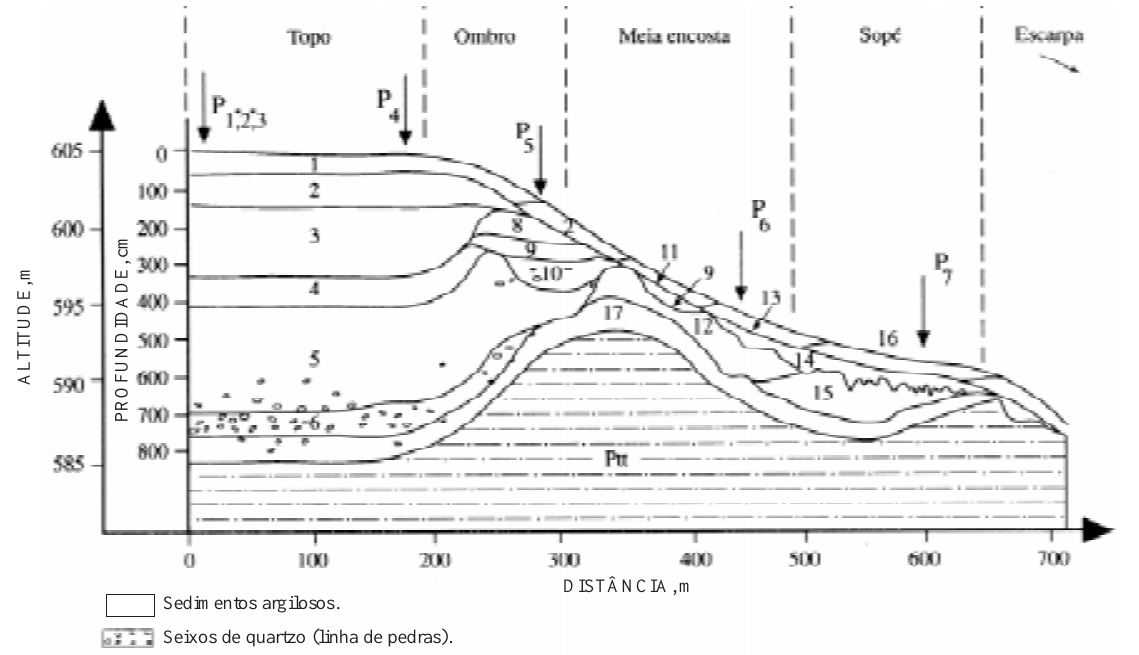
Figura 1. Perfil topográfico da seqüência estudada contendo: delimitação dos segmentos da vertente; posição dos perfis; configuração lateral dos horizontes, da linha de pedras e da rocha subjacente. 1,2,...17: horizontes do solo (Quadro 1). A transeção escolhida atravessa um remanescente de uma antiga superfície, que é a mais elevada e plana da região. Os perfis de 4 a 7 situam-se na borda do platô. O material inconsolidado neocenozóico coincide com o Latossolo (perfis 1 a